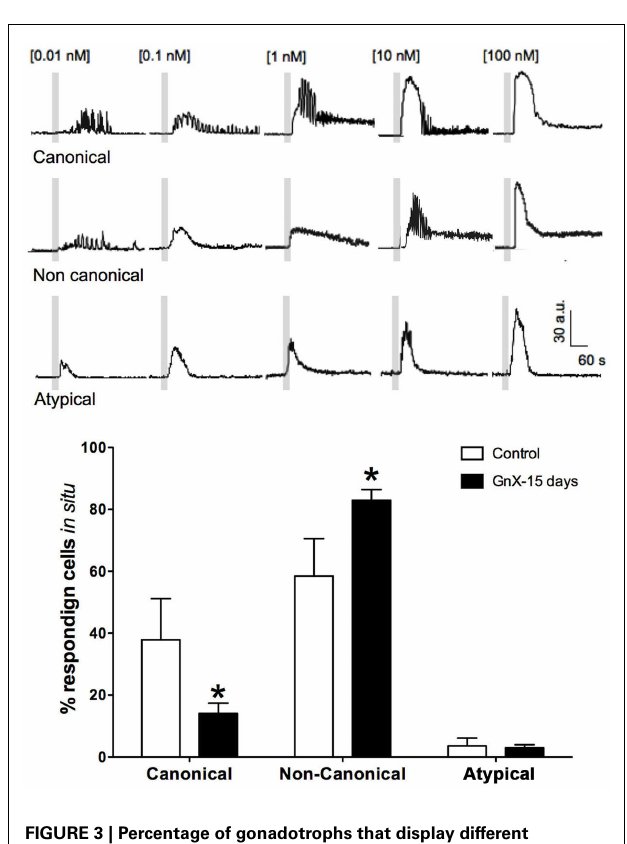
FIGURE 3 | Percentage of gonadotrophs that display different GnRH dose-response intracellular Ca 2 + signaling patterns rises in response to increasing GnRH: canonical ([Ca 2 + ] i oscillations of increasing frequency at low-medium GnRH concentration and spike-plateau at saturating GnRH concentration), non-canonical (disordered sequence of oscillatory and spike-plateau [Ca 2 + ] i signals in response to increasing GnRH concentrations), and atypical (non-oscillatory, transient [Ca 2 + ] i ); open bars represent data from intact mice and black bars those of castrated mice after 15 post-GnX . After orchidectomy, non-canonical responses increased, while the fraction of cells with canonical responses declined. Differences between intact and post-GnX, for both canonical and non-canonical responses are significant. * p < 0.05 versus the control (two way ANOVA with Bonferroni post hoc test). Parts of this figure were originally published in Durán-Pastén et al.,